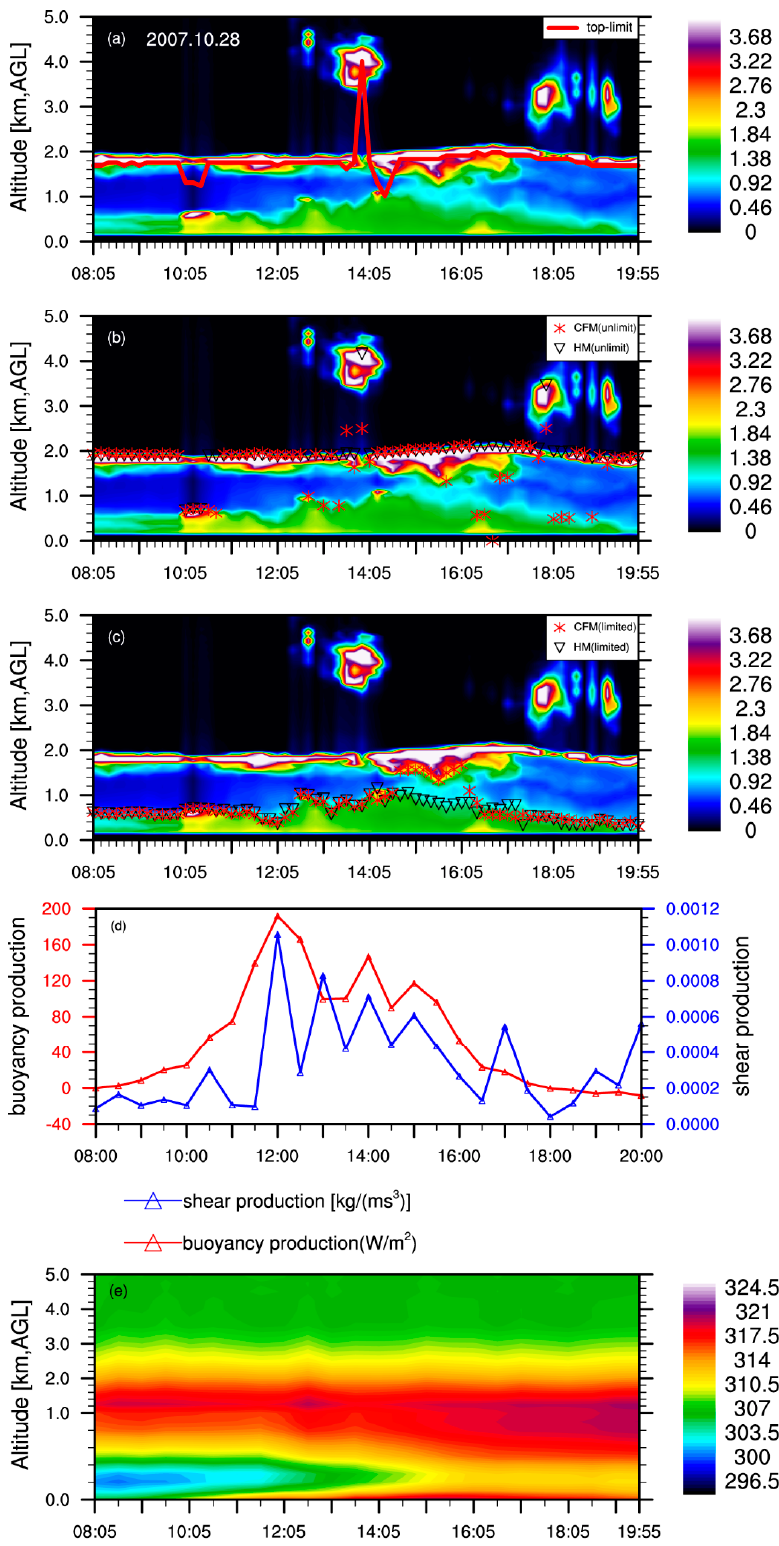
Figure 11. Same as in Figure 9, but on 28 October